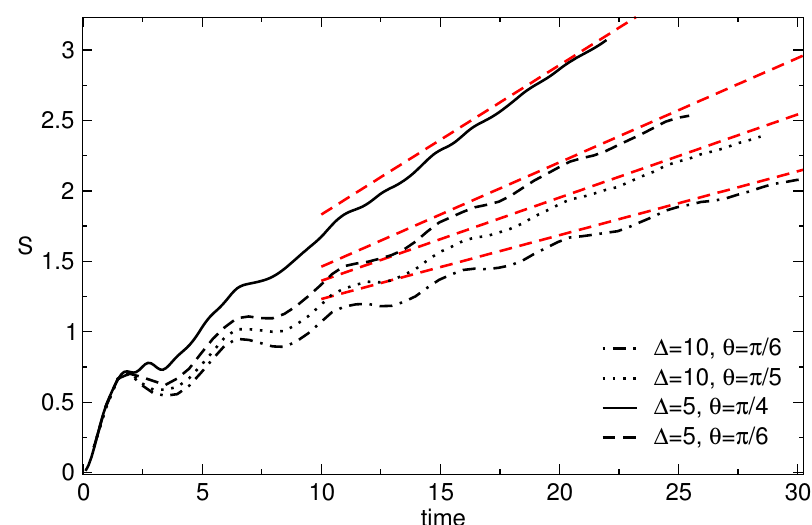
Figure 7: Entanglement dynamics after a bipartite quench in the XXZ chain. In the initial state two semi-infinite chains are prepared in the Néel state | N,0 〉 (24) (left) and the tilted ferromagnetic state (25) (right), respectively. The figure shows the half-chain entropy plotted versus the time after the quench. The different curves are tDMRG data for the chain with ∆ = 5,10 and several values of θ (tilting angle). The dashed lines are linear fits. The slope of the lines is fixed by the prediction of the quasiparticle picture